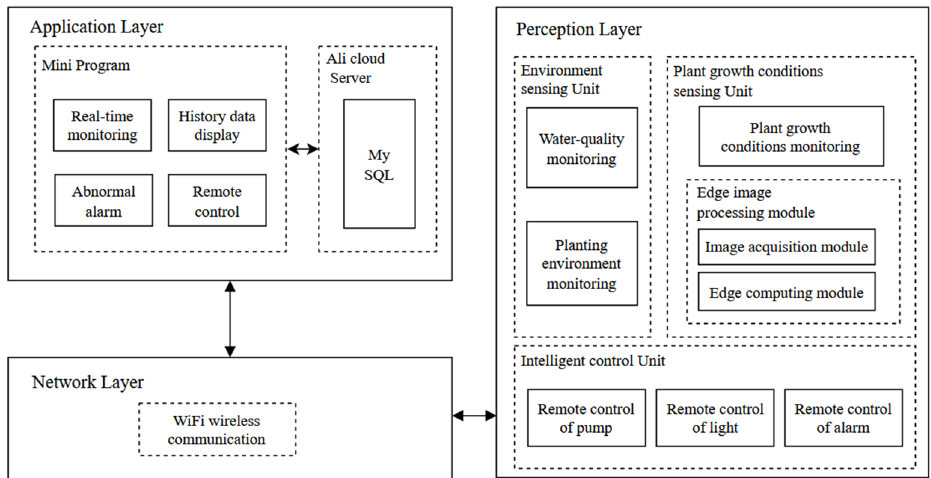
Figure 1. The general framework of the system.